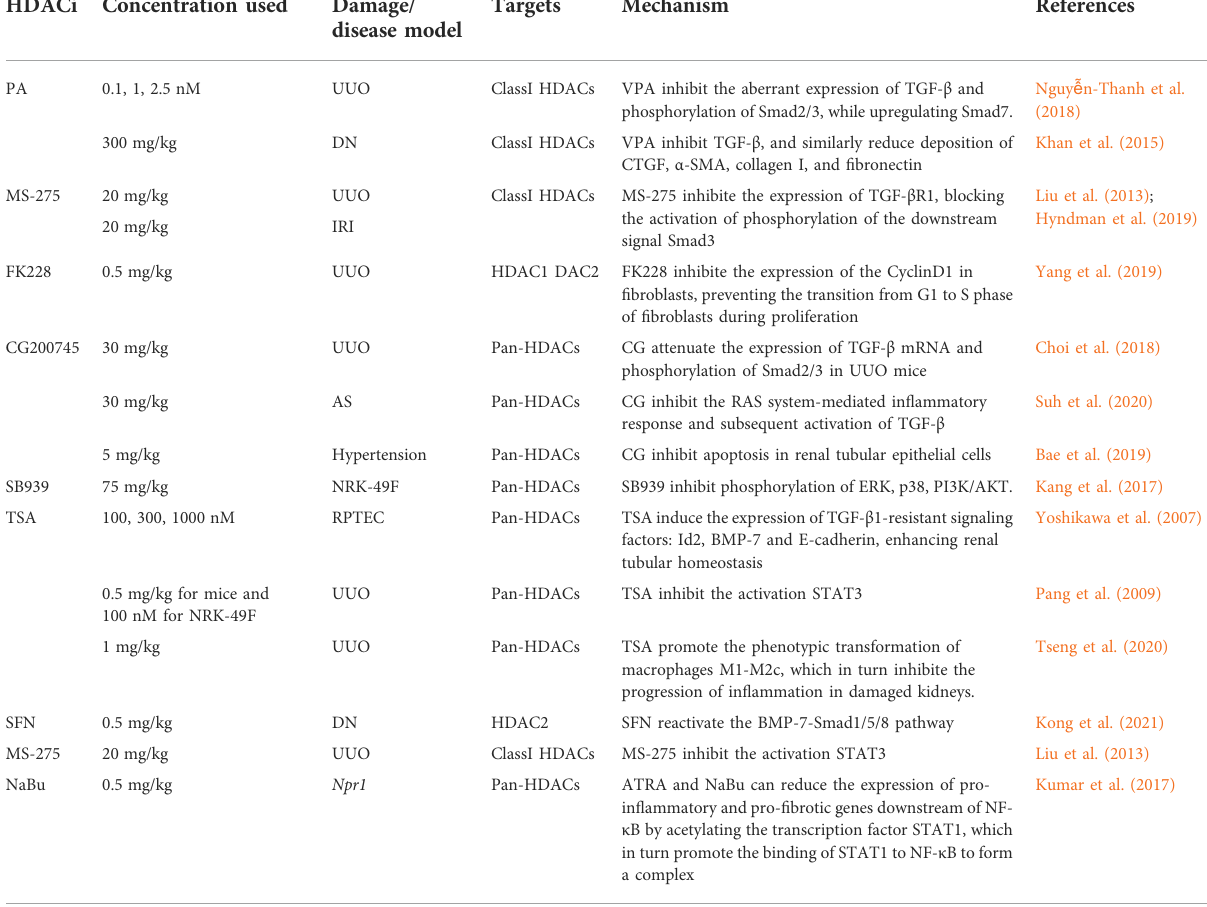
TABLE 2 Reversal of renal fi brosis by HDAC inhibitors in different disease models.